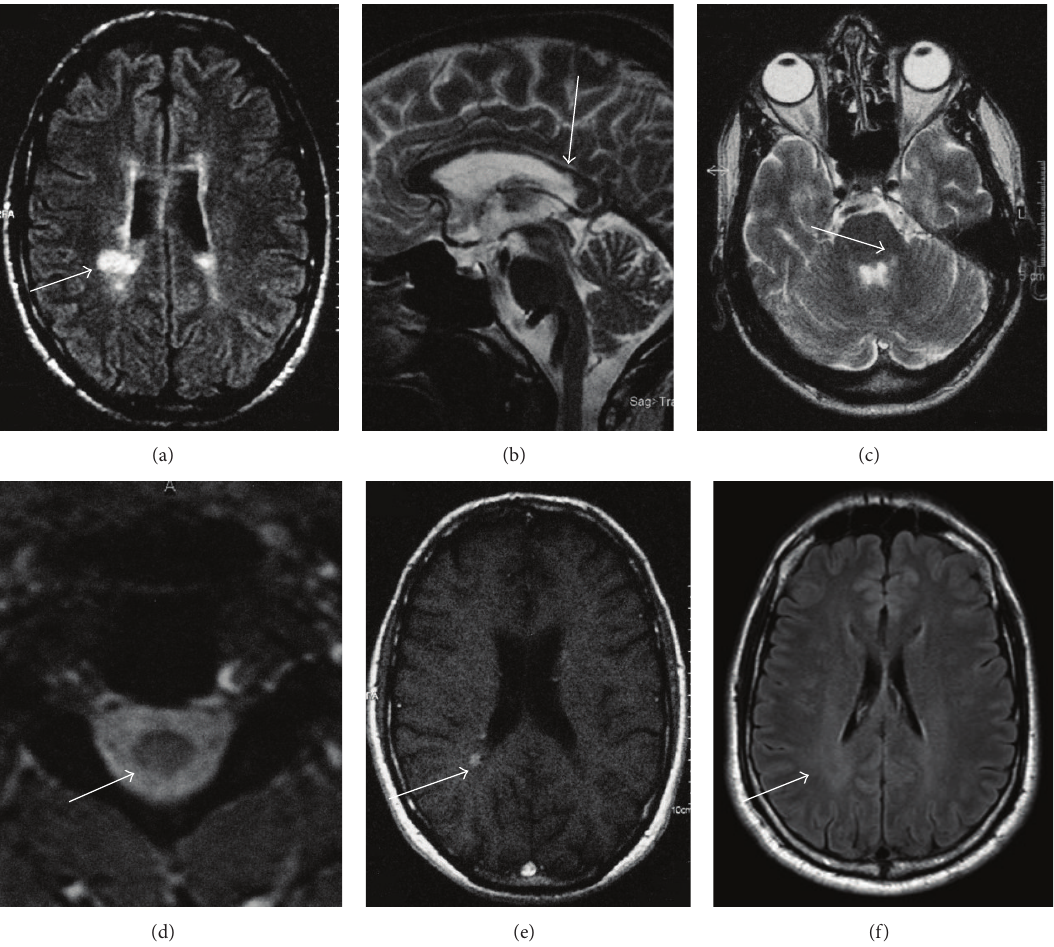
Figure 1: Brain and spinal cord MRI of the patient with CMTX and MS and brain MRI of his first cousin with CMTX and asymptomatic diffuse CNS involvement. (a) Axial FLAIR brain MRI of the patient demonstrating periventricular lesions characteristic of MS. (b) Sagittal T2 brain MRI of the patient revealing lesions in the corpus callosum characteristic of MS. (c) Axial T2 brain MRI of the patient demonstrating a lesion in the left middle cerebellar peduncle. (d) Axial T2 cervical cord MRI of the patient demonstrating a spinal cord lesion. (e) Axial T1 with IV contrast brain MRI of the patient showing periventricular gadolinium-enhancing lesions suggesting inflammation. (f) Axial FLAIR brain MRI of the patient’s first cousin revealing diffuse white matter hyperintensity more prominent